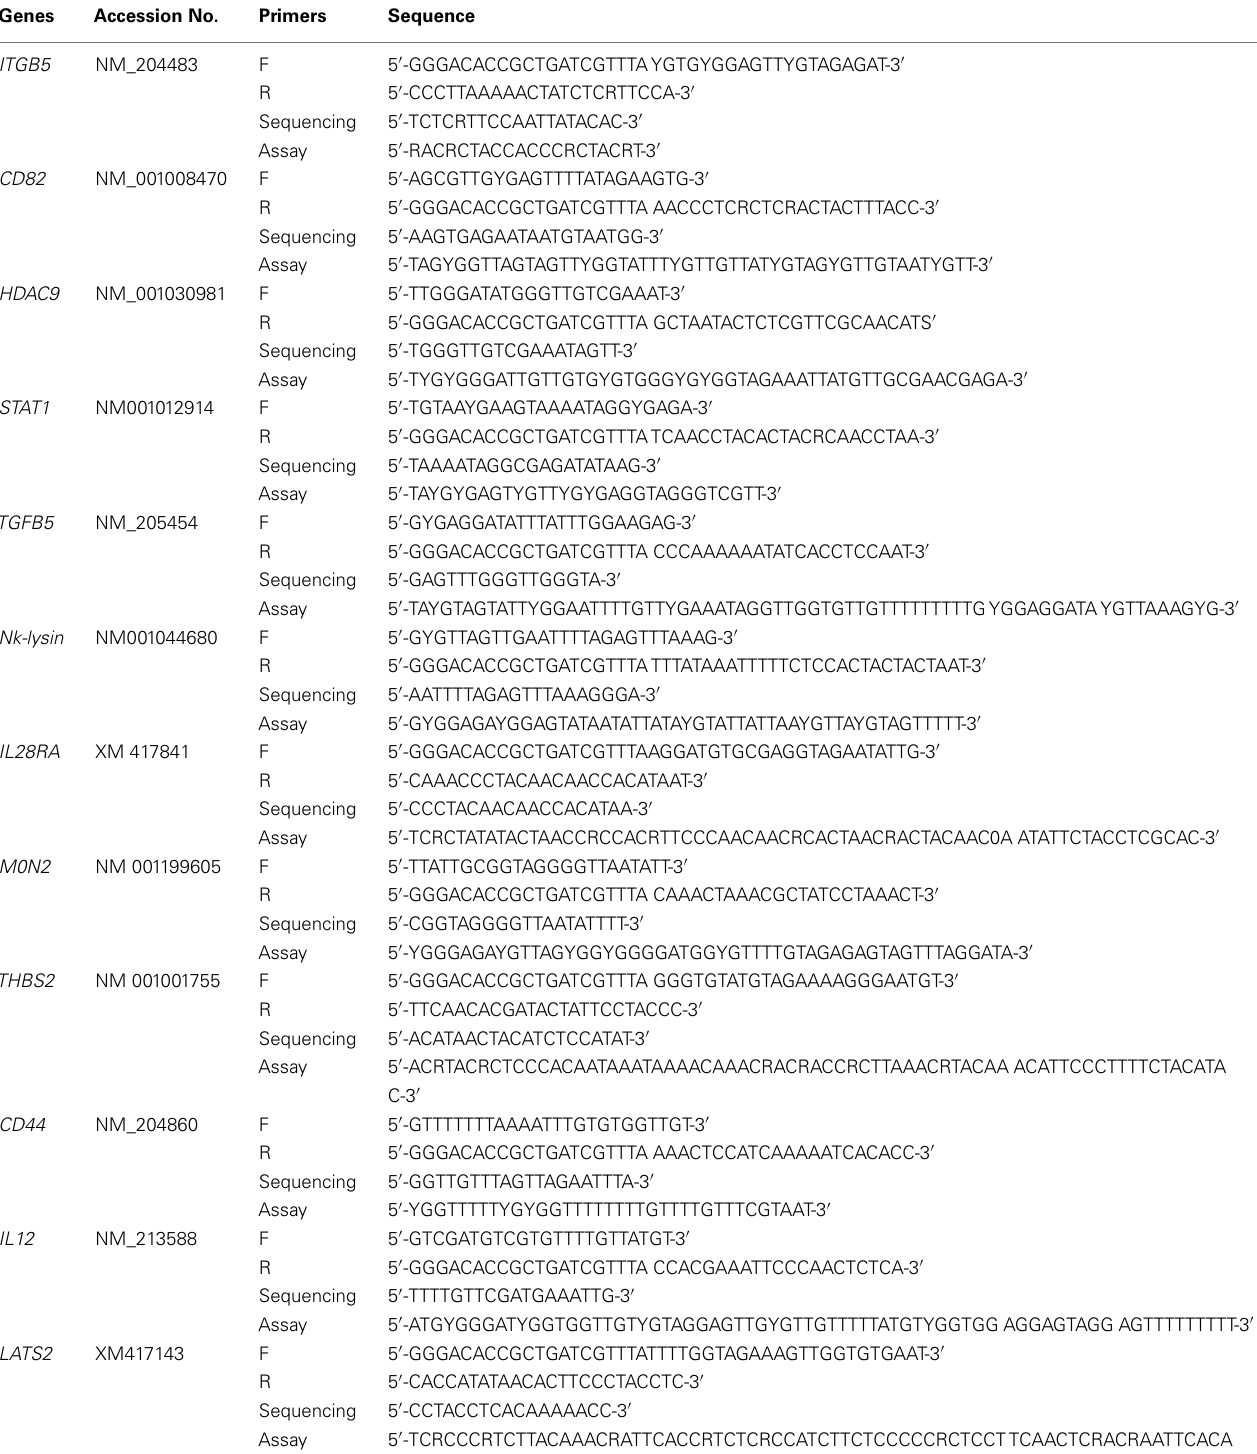
TableA1 | Primers for pyrosequencing analysis of promoter